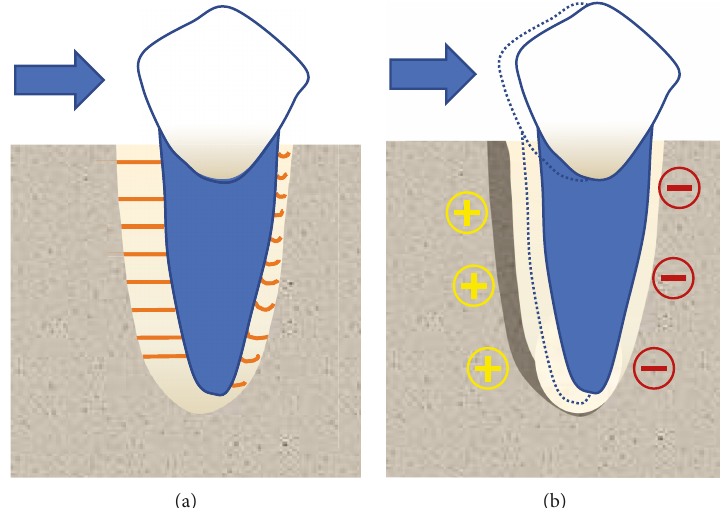
Figure 1: Bone remodelling during orthodontic tooth movement. (a) Initial displacement of the tooth due to stretching of the fi bres within the PDL on the tension side and compression on the opposite with the application of the orthodontic force. (b) Bone apposition on the tension side and resorption on the compression side as the result of the long-term force